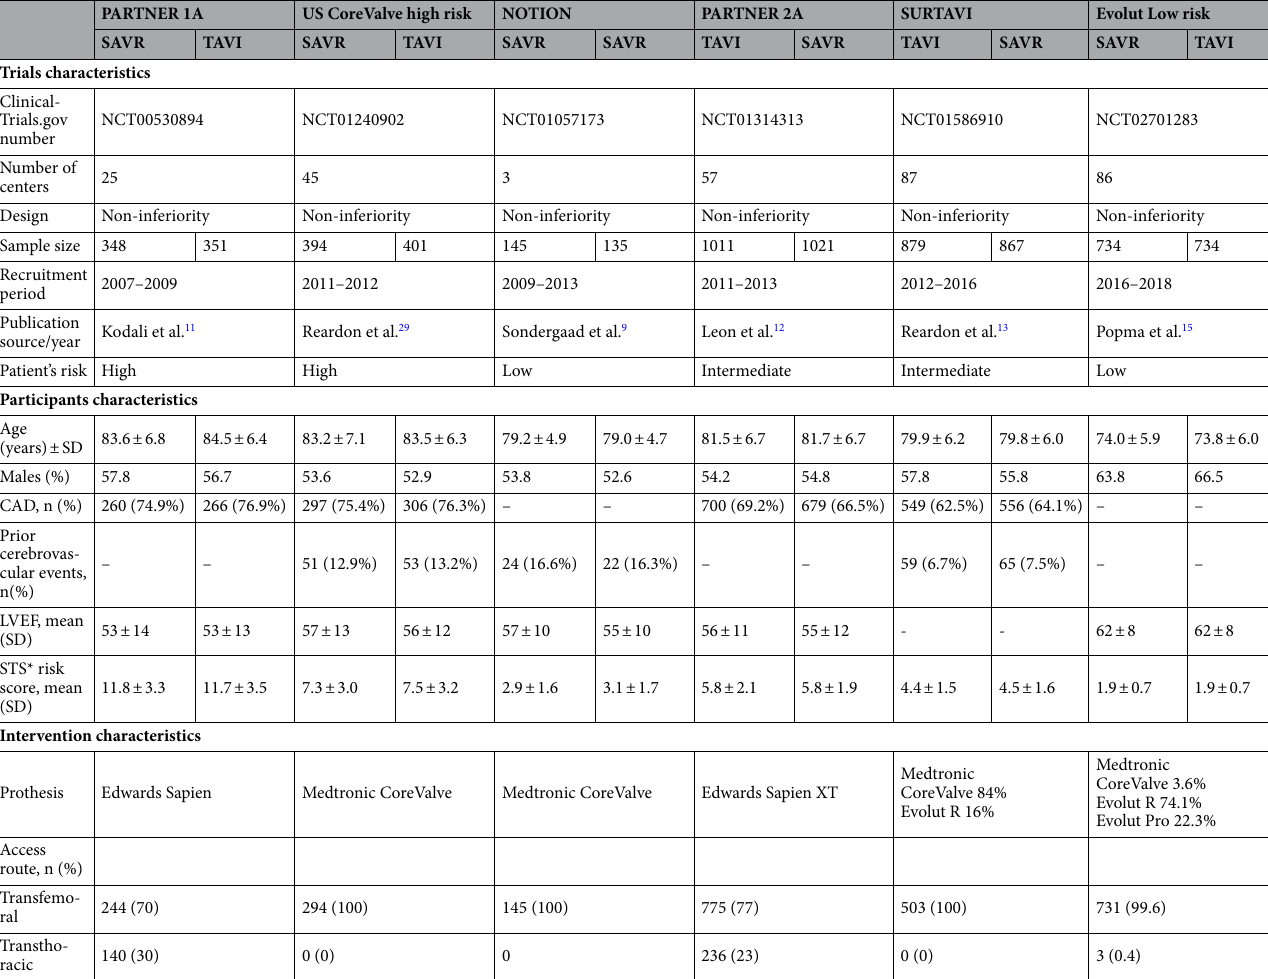
Table 1. Trials and participants